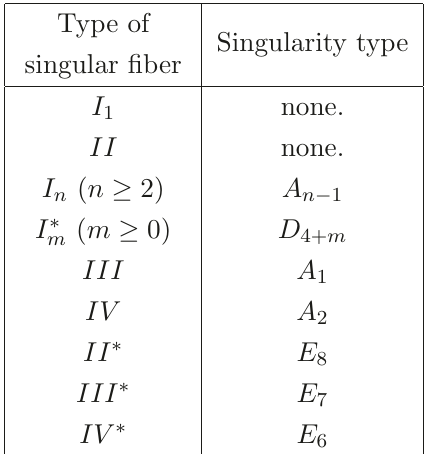
Table 1 . Correspondences of types of singular fibers and the singularity types of the compactifi- cation